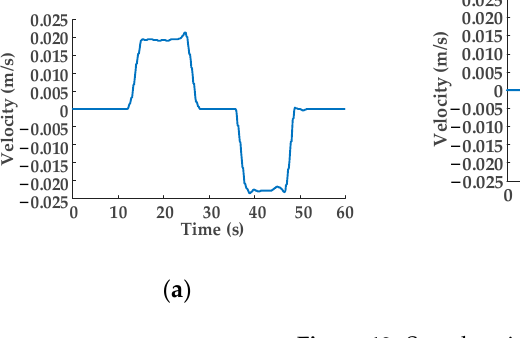
( c ) Figure 11. Speed variation curves of the hydraulic cylinder piston rod: the pressure setting values of relief valve 5.2 are ( a ) 3.5 MPa; ( b ) 3.0 MPa; ( c ) 2.5 MPa. 5. Conclusions A new configuration for a hydraulic transformer, namely, a digital hydraulic trans- former, is proposed for the CPR secondary regulation system. DHT is formed by rigidly connecting the output shafts of four gear–pump/motor units with a displacement ratio of 1:2:4:8, and eight solenoid directional valves are installed on the inlet and outlet of gear– pump/motor units. Through the binary digital control of the DHT inlet and outlet control valve groups, changing the flow direction and size of oil port T is possible. In turn, such change alters the output flow of oil port A and achieves the objective of changing the output pressure of oil port A. A theoretical study of DHT is performed, the variable pres- sure principle of DHT is analyzed, and the binary digital combination states of the DHT inlet and outlet control valve groups are summarized. A conclusion is drawn that this DHT, which is composed of four gear–pump/motor units, has 225 control coding meth- ods, and ideally, an output pressure range of 1/15 to 15 times relative to the input pressure can be achieved. A dynamic simulation model of the hydraulic traction system based on DHT is es- tablished, and the pressure/flow of DHT and the hydraulic traction system is simulated. A conclusion is drawn that the speed and displacement of the hydraulic cylinder piston rod can be controlled through the binary digital control of the eight solenoid directional valves, verifying the rationality of the design circuit of the hydraulic traction system. Fi- nally, the speed control of the hydraulic cylinder piston rod of the hydraulic traction sys- tem based on DHT is experimentally verified by relying on an experimental simulation platform. The results show that the designed digital hydraulic transformer can change the output flow of the hydraulic traction system through digital control.